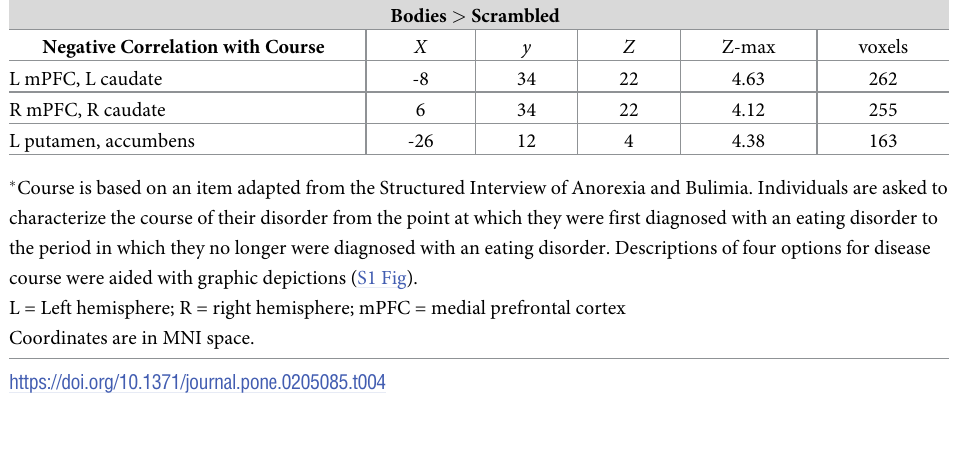
Table 4. Regions of activation associated with illness course � within mPFC and striatal regions of